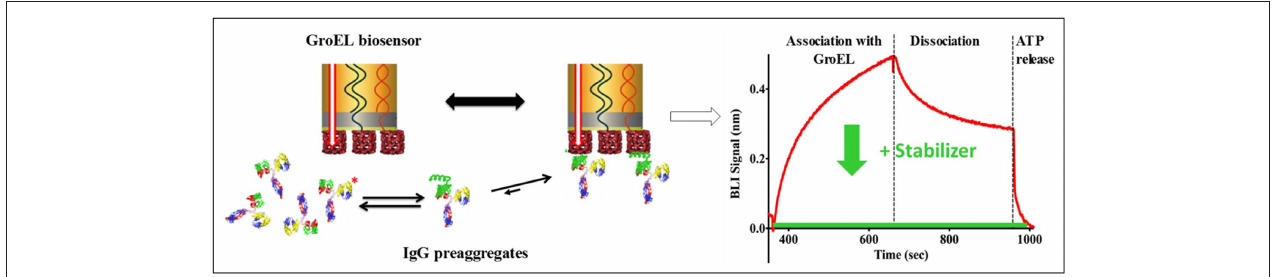
FIGURE 2 | General Scheme on the Use of Biolayer Interferometry and GroEL Biosensor . The biosensor can be used to detect the appearance of pre-aggregates (here shown on the left as IgG localized unfolding (green helix). The GroEL biosensor can capture the unfolded region even though the majority of the IgG is properly folded. On the right-hand side, a representative sensogram is shown where association and dissociation phases can easily be seen. The dissociation is non-specific interactions. This is confirmed by specific interaction reversal by ATP addition. The green curve demonstrates how a specific stabilizer could limit IgG association with